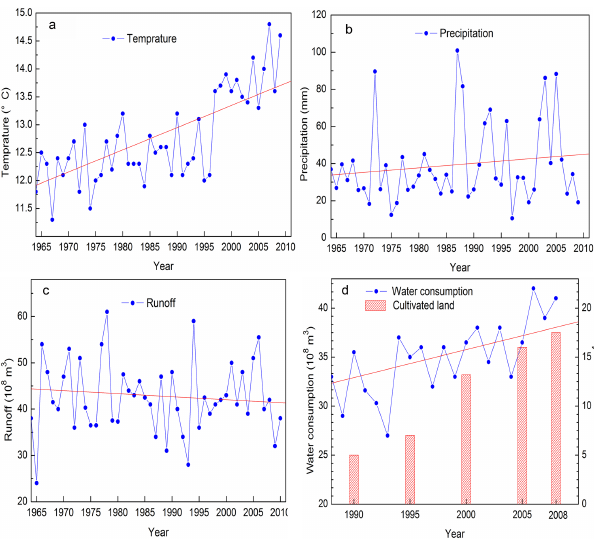
Figure 4. Distribution of areas showing change occurrence among land cover types across the two periods from 1990 to 2008.